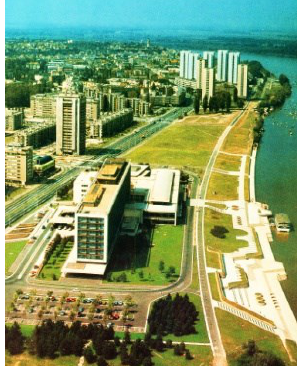
Figure 7. The river coast arrangement next to Hotel "Jugoslavija"(photo was given by the author BranislavJovin) Although the fact